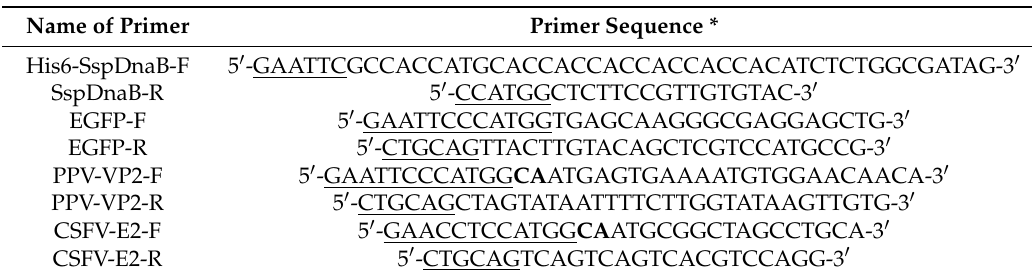
Table 1. Primers used in this study.